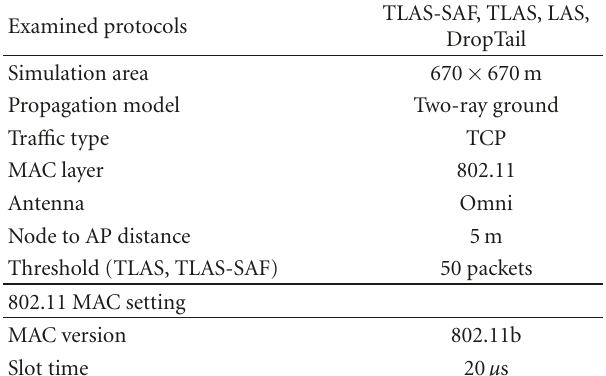
Table 2: Common simulation setup parameters for all simulations. Examined